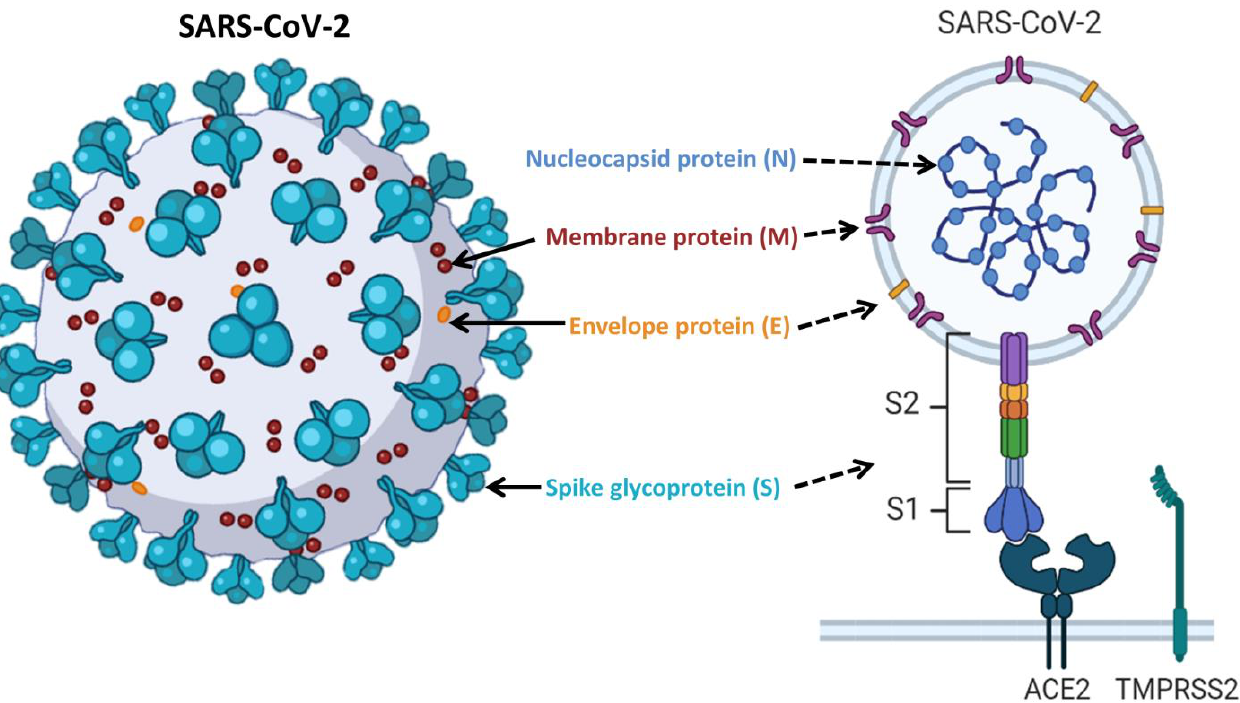
Figure 1. Schematic presentation illustrating the different components of SARS-CoV-2. The three- dimensional SARS-CoV-2 structure ( left panel ) shows the viral surface proteins (spikes, envelopes, and membranes) embedded in a lipid bilayer envelope. The internal structure ( right panel ), shows the corresponding protein in addition to the interior nucleocapsid protein which is associated with the single-stranded positive sense viral RNA. The interaction between the S-protein trimer of SARS- CoV-2 and the ACE2 receptor is shown in lower right. Upon binding to the receptor binding domain (RBD) of the S1 subunits, the S protein is primed with TMPRSS2 facilitating the release of the viral genome through S2-assisted fusion.